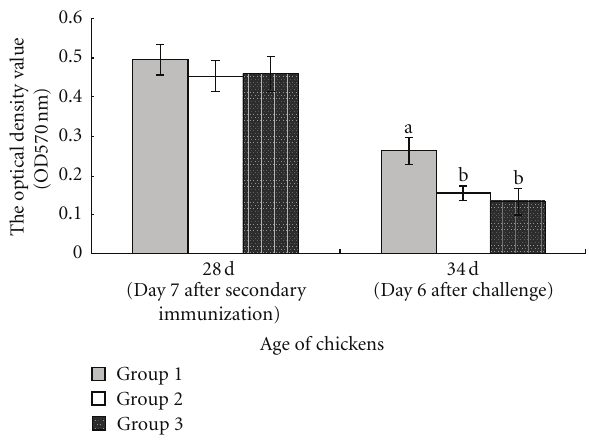
Figure 1: E ff ect of immunization with pcDNA-3-1E-mChIL- 15 on spleen lymphocyte proliferation. Seven-day-old chickens were divided into three groups. Chickens in each group were, respectively, intramuscularly immunized with 100 μ g pcDNA-3- 1E-linker-mChIL-15 (group 1), 100 μ g pcDNA3.1 (group 2), and sterile TE bu ff er (pH 7.6) (group 3) at 14 days of age. A booster immunization was given at 21 days of age. All chickens were inoculated orally with 5 × 10 4 sporulated oocysts of E. acervulina at 28 days of age (day 7 after secondary immunization). The proliferative response of spleen lymphocytes to stimulation with Con A was measured by MTT methods at day 28 and 34 days of age (day 6 after challenge). Data were expressed as means ± standard errors ( n = 5 per group). Bars not sharing the same small letter are significantly di ff erent according to Duncan’s multiple range test ( P < 0 . 05) in each time